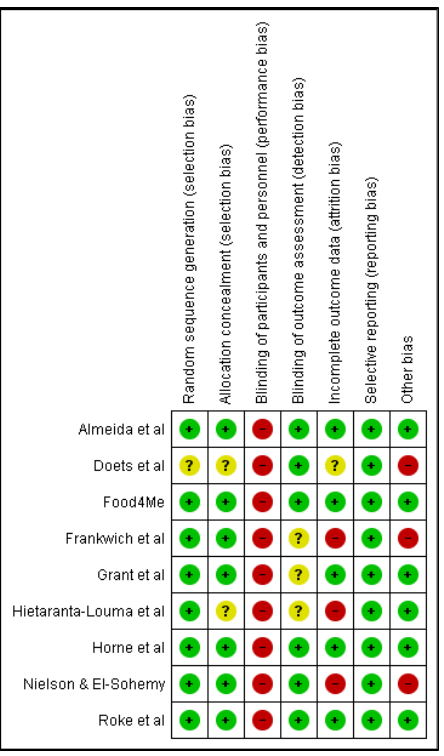
Figure 2. Risk of bias summary of included studies (N = 9)